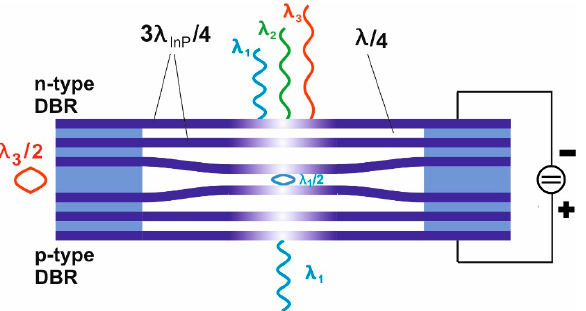
Figure 11. MEMS tunable FP filters with multiple airgaps and InP membranes and suspensions. The supporting posts consist of the corresponding InP/InGaAs multilayer stack. Partly, InGaAs is used as sacrificial layer.